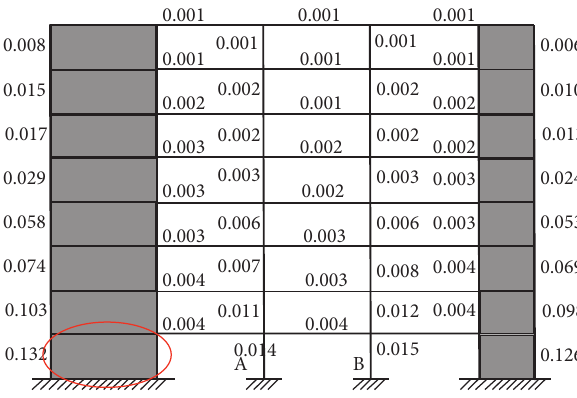
Figure 9: The distribution of importance coefficients of different structural component.